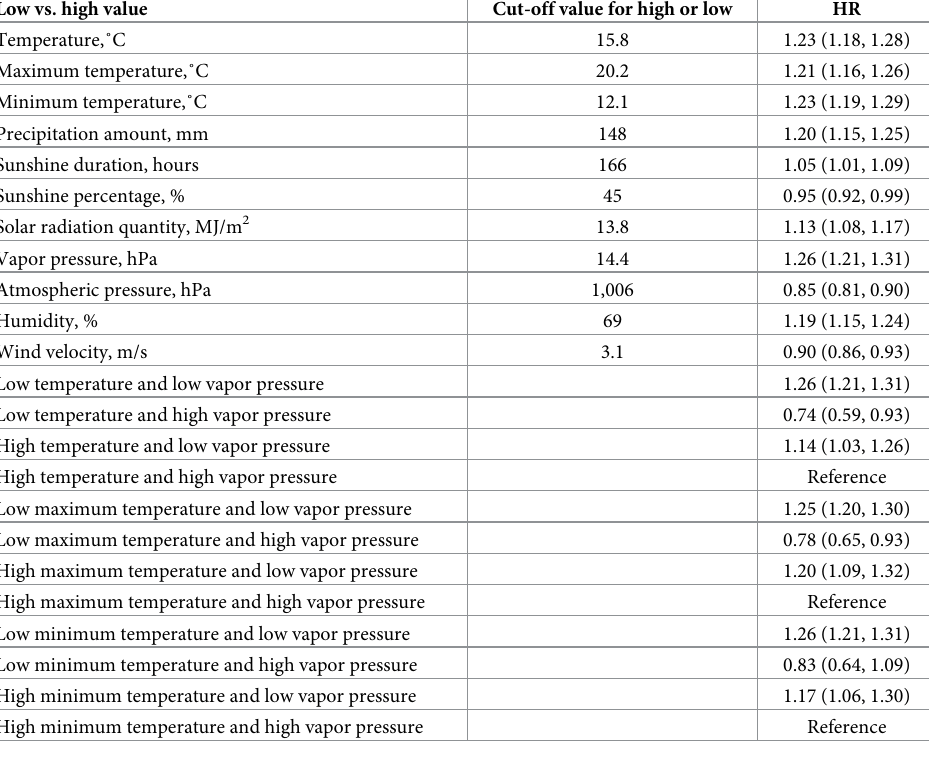
Table 3. HRs (95% confidence intervals) of the incidence of atopic dermatitis for a low vs. high mean climate con- dition from birth to 6 months. Low vs. high